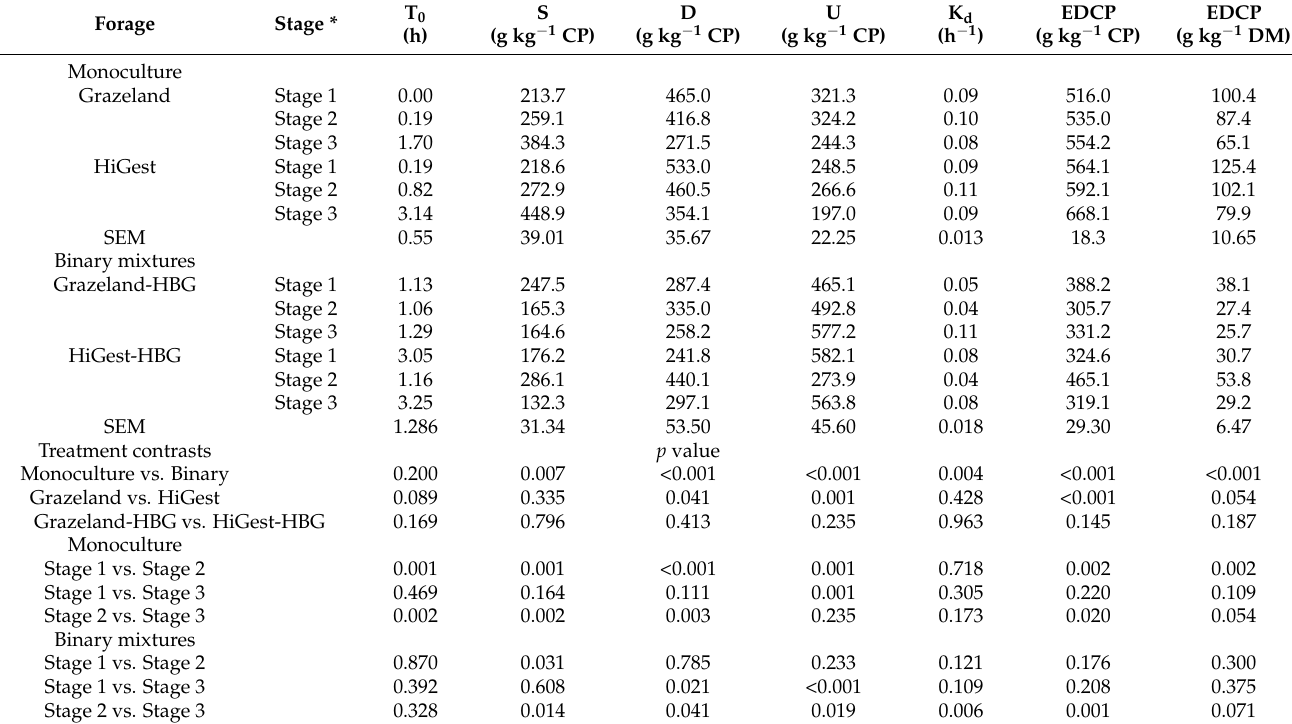
Table 5. Effects of cultivar, maturity, and their interaction on in situ rumen degradation kinetics of CP of alfalfa cultivars in monoculture and in binary mixtures with AC Success hybrid bromegrass (HBG) in Lanigan, Saskatchewan Canada in